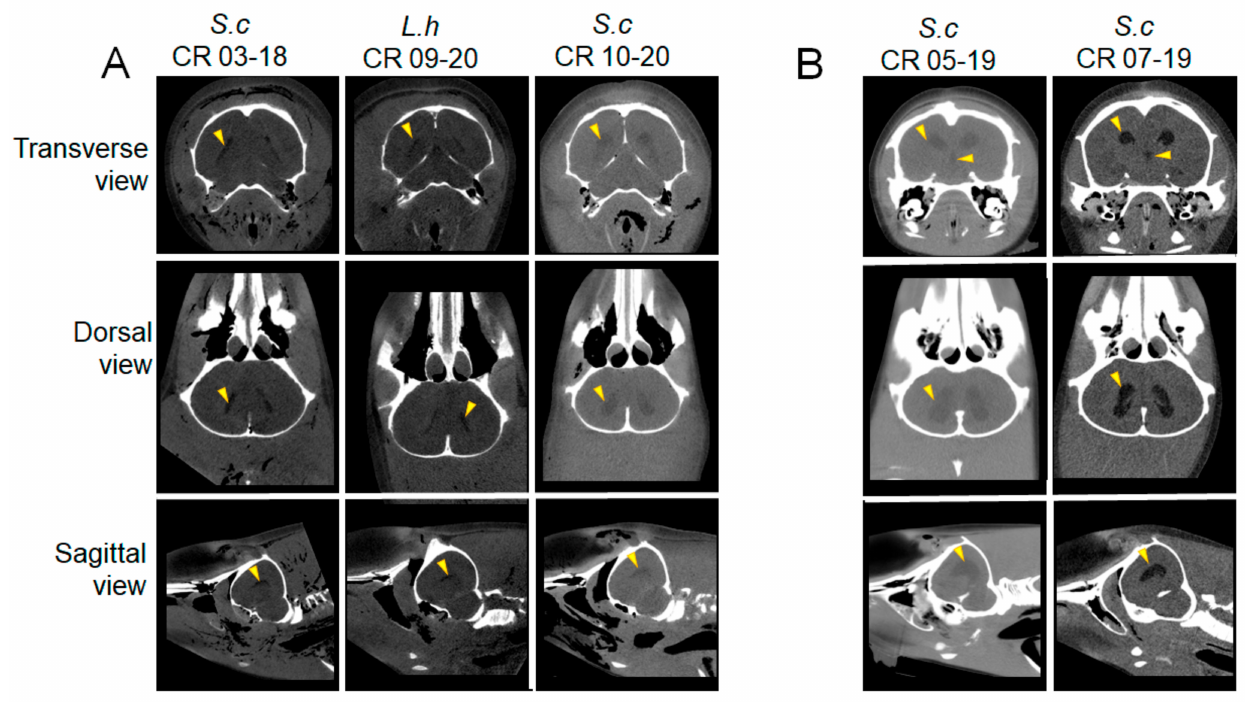
Figure 2. Reconstruction by PMCT of transverse, dorsal, and sagittal virtual brain sections of adult dolphins with neurobrucellosis, showing mild ventriculomegaly (yellow point arrows). ( A ) Mild ventriculomegaly. ( B ) Moderate ventriculomegaly. The planes of the virtual computed tomography sections are as presented in Figure 1. S.c , S. coeruleoalba ; L. h , Langenodelphis hosei .